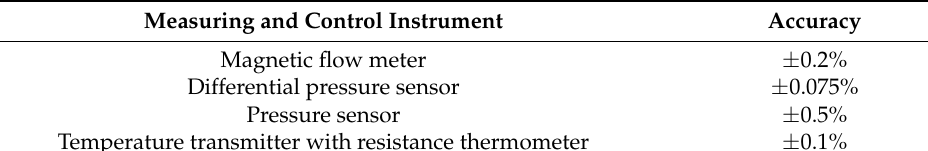
Table 5. Manufacturer specification of all measuring instruments.